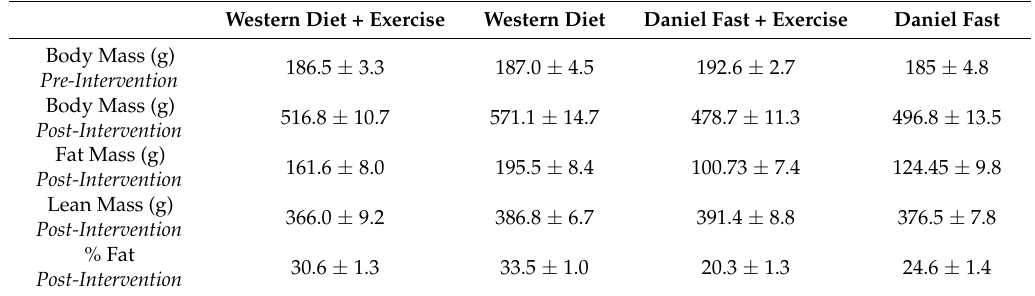
Table 3. Anthropometric data of male rats assigned to two different diets with and without exercise.